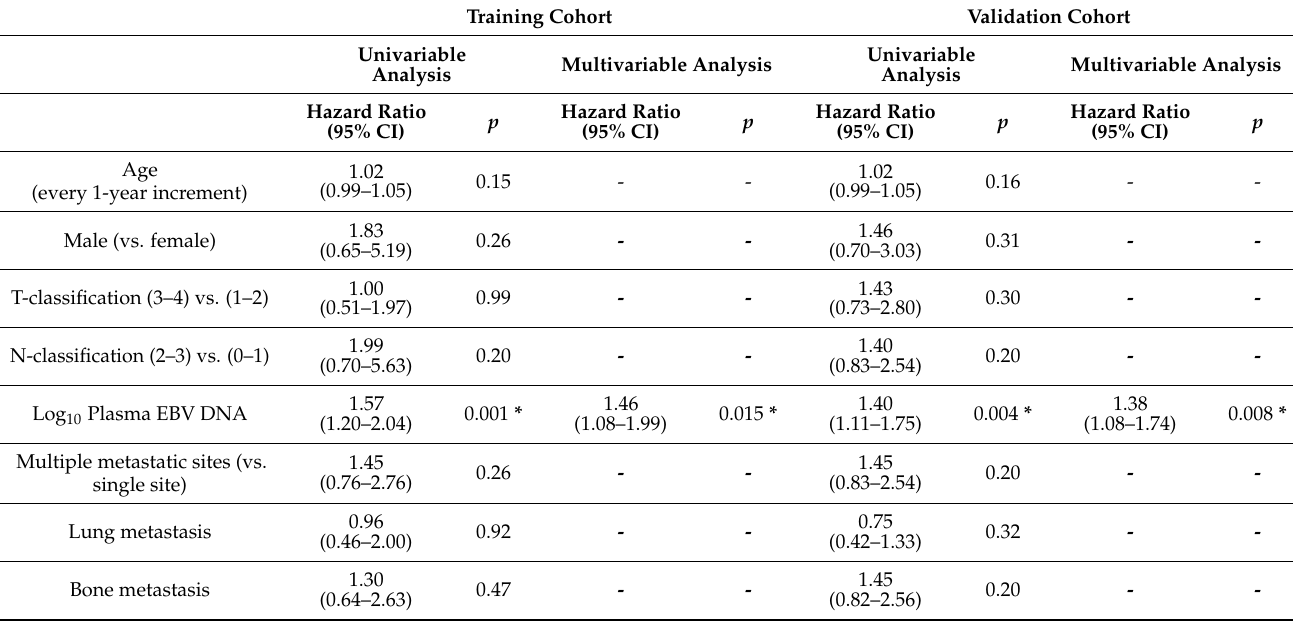
Table 4. Second-round univariable and multivariable analyses of prognostic variables of overall survival with the addition of pre-treatment plasma EBV